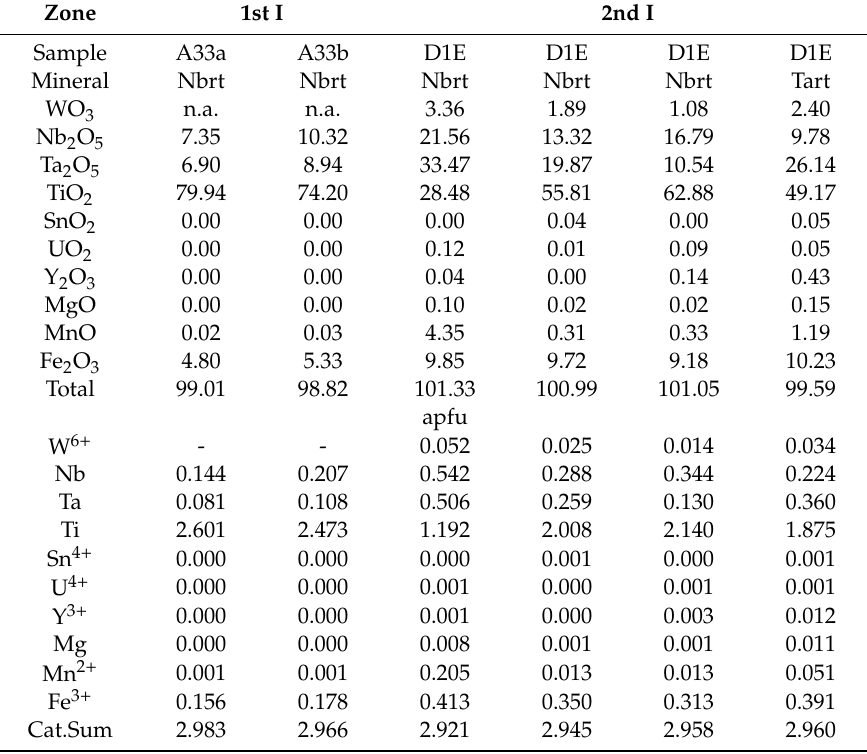
Table 4. Representative chemical composition (wt.%) of niobian rutile (Nbrt) and tantalian rutile (Tart) from the Type-IV